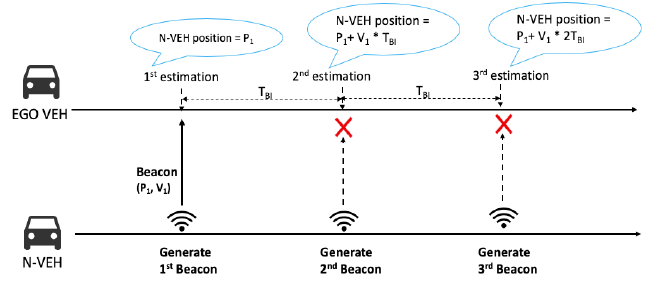
Figure 2. The method for estimating a neighbor’s evolving position varies depending on whether an ego vehicle receives a beacon.